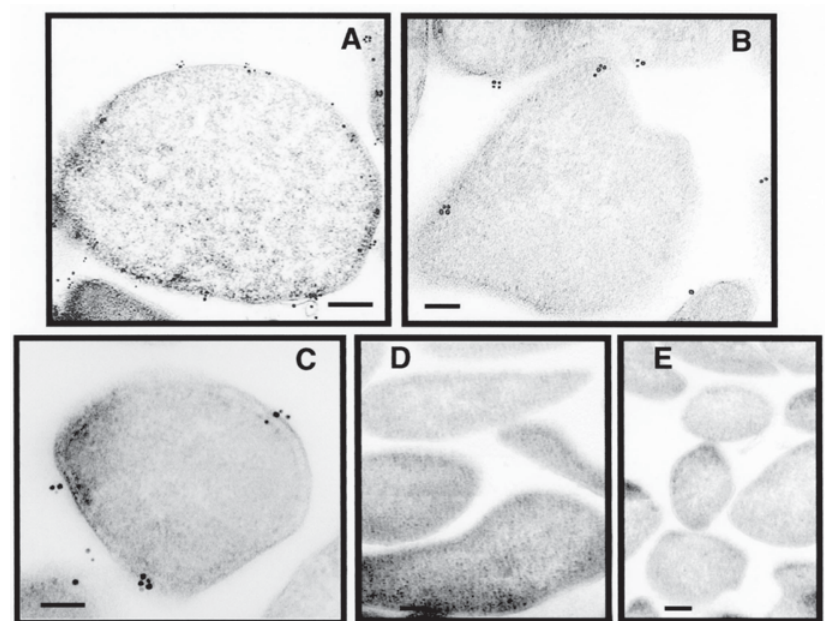
Figure 4. The Dld and NoxA2 co-lo- calize in the membrane. Ultra-thin sec- tions (80–200 nm) in A, B and C were treated with anti-Dld (from chicken) and anti-NoxA2 (from rabbit) followed by anti-rabbit antibody conjugated with 10-nm gold particles and anti-chicken antibody conjugated with 18-nm gold particles. Thin sections in Panels D and E were treated only with secondary an- tibodies. Photographs were taken under a JEOL transmission electron micro- scope. Bar = 50